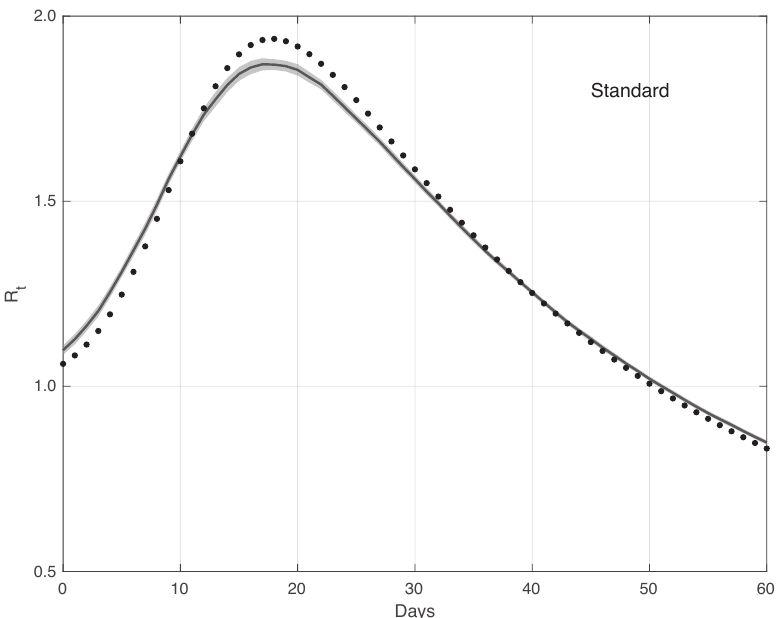
Figure 13. Mean of the R t curve estimated by the standard method from a realistic SARS-CoV-2 first symptoms synthetic data sample ( n = 100 ) . The relative 95% CI is shown as a grey shadow. The “true” R t sequence is given as a dotted line. The mean is obtained from 100 independent realizations of the synthetic